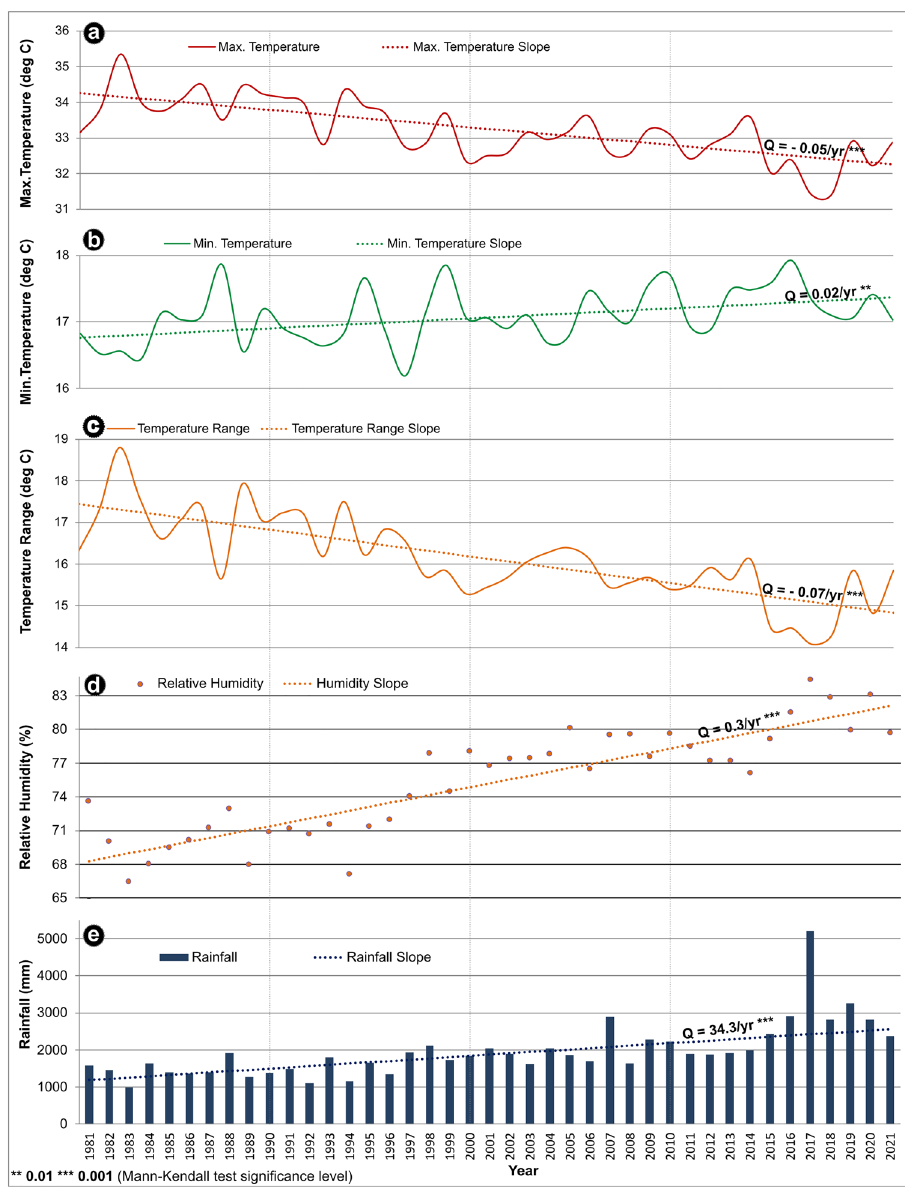
Figure 8. Long-term trends in ( a ) Maximum temperature; ( b ) Minimum temperature; ( c ) Temperature range; ( d ) Relative humidity; ( e ) Rainfall in the Western region of Mizoram. The dotted lines in the graphs show Sen’s slope, and the rate of change per year (Q) with the statistical significance (based on the Z-value of the Mann– Kendall test) is appended above the